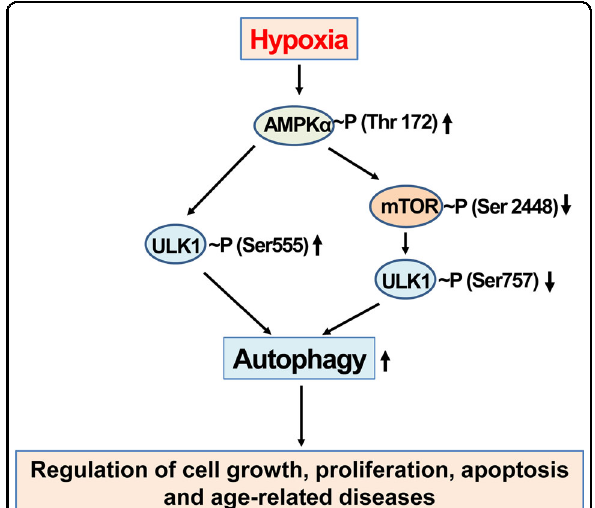
Fig. 5 The relationship among AMPK, mTOR, ULK1 and autophagy under hypoxic conditions. During hypoxia, the levels of phosphorylated AMPK (Thr172) and phosphorylated ULK1 (Ser555) increase, and the levels of phosphorylated mTOR (Ser2448) and ULK1 (Ser757) decrease, resulting in an increase in autophagy which is responsible for regulating cell growth, proliferation, apoptosis and age-related